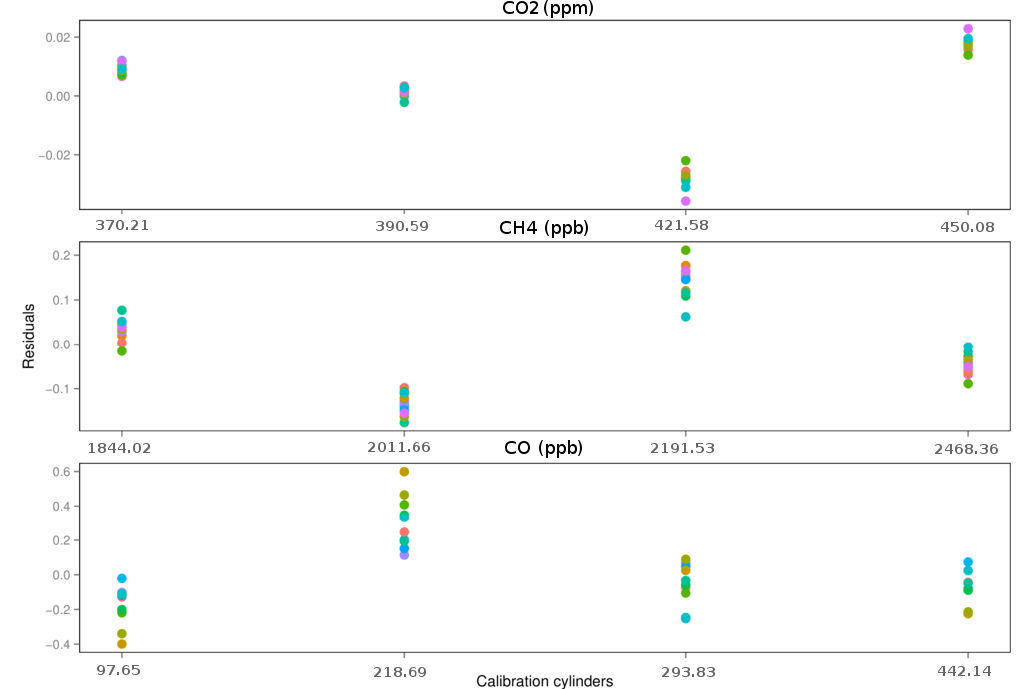
Figure 9. Calibration residuals for one set of cylinders measured on 14 different instruments. Each point is the average residual for each instrument for one calibration cylinder. For each cylinder, the reference concentration is indicated.